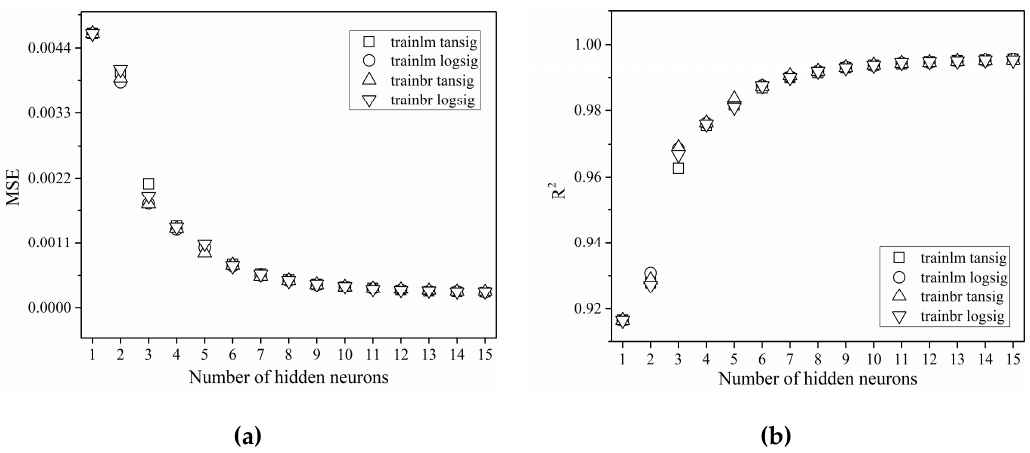
Figure 1. The effect of number of hidden neurons, training algorithm and transfer function between the input and the hidden layer to: ( a ) MSE (mean square error); ( b ) R 2 (coefficient of determination).